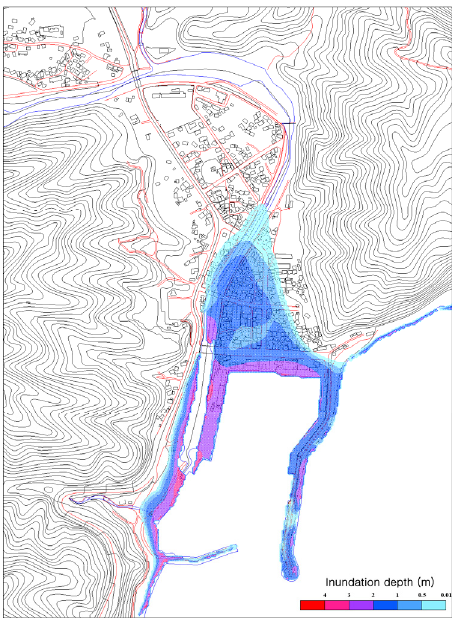
Figure 8. Maximum inundation depths and area derived from 14 numerically modeled cases in Imwon Port.